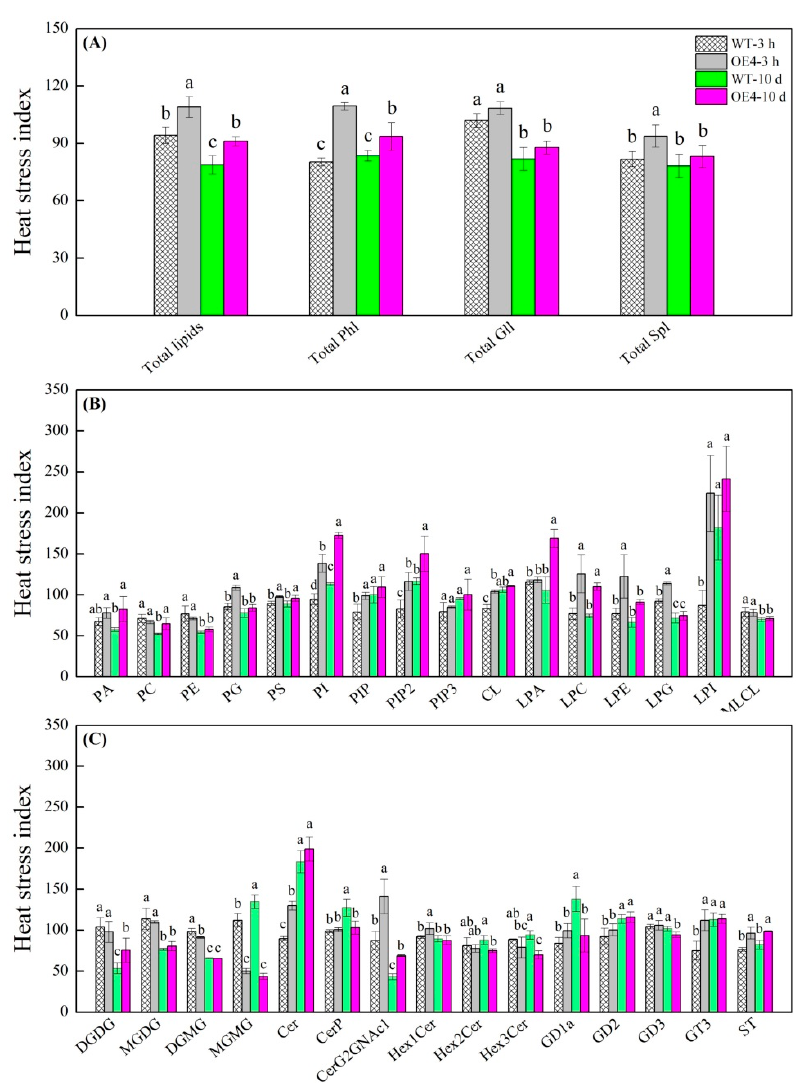
Figure 6. Changes in heat stress index of ( A ) total lipids, total phospholipids (Phl), total glycoglycerolipids (Gll), and total sphingolipids (Spl), ( B ) different Phl classes, and ( C ) different Gll and Spl classes in leaves of wild type (WT) and transgenic Arabidopsis thaliana (OE4) overexpressing the TrSAMS involved in spermidine biosynthesis during heat stress. Vertical bars indicate ±SE of mean ( n = 4) and different letters above column indicate significant differences ( p ≤ 0.05) among treatments.